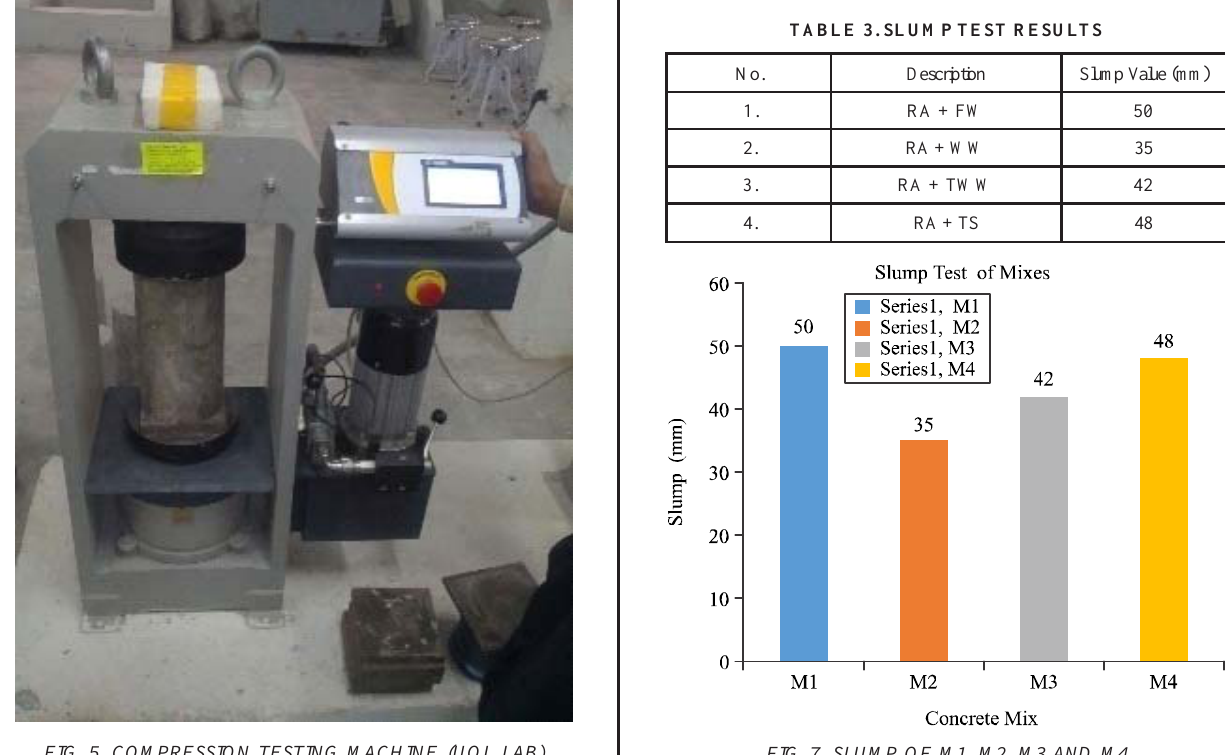
FIG. 7. SLUMP OF M1, M2, M3 AND